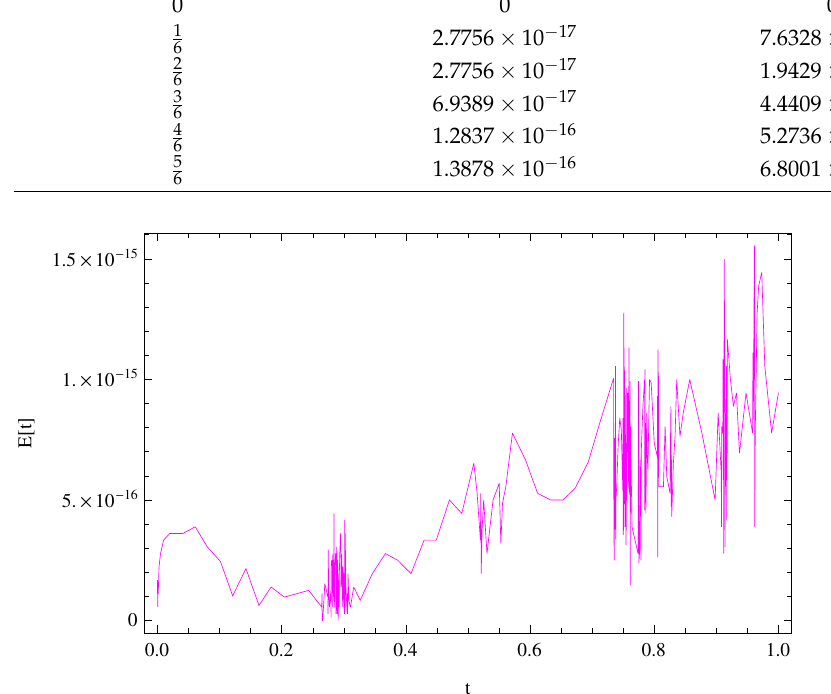
Figure 5. The E ( t ) of Example 3 for N = 4, ( σ , ρ ) = ( 1